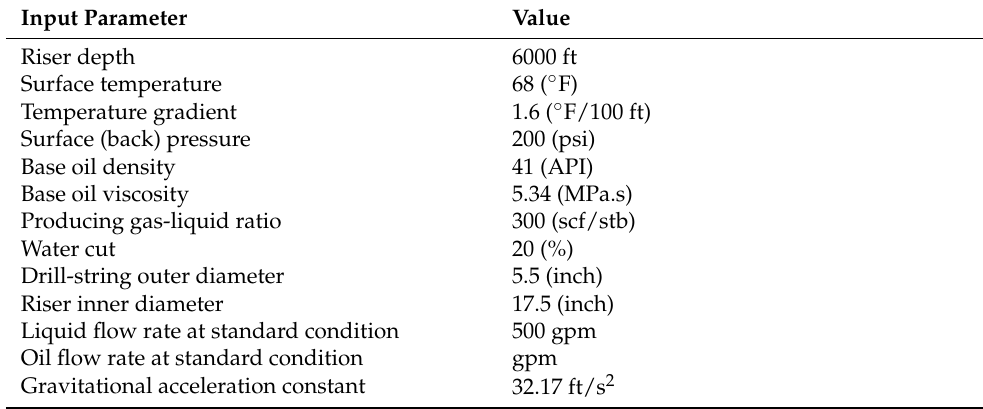
Table 1. Values of the constant parameters in the calculation of the different PVT